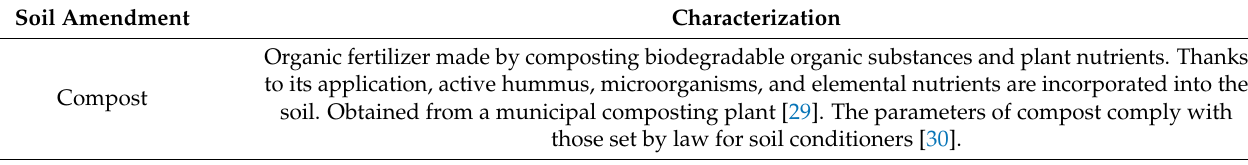
Table 1. Characterization of soil amendments.